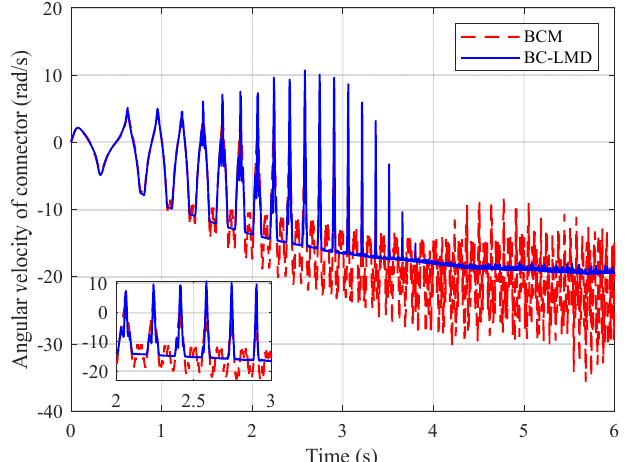
Figure 8. Lower bound of the angular velocity of the connector.